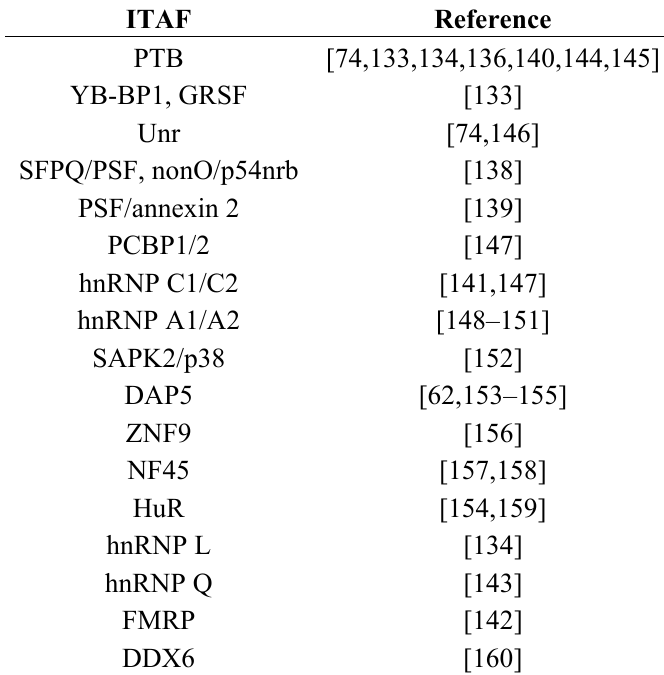
Table 3. RNA-binding proteins m odulating cellular